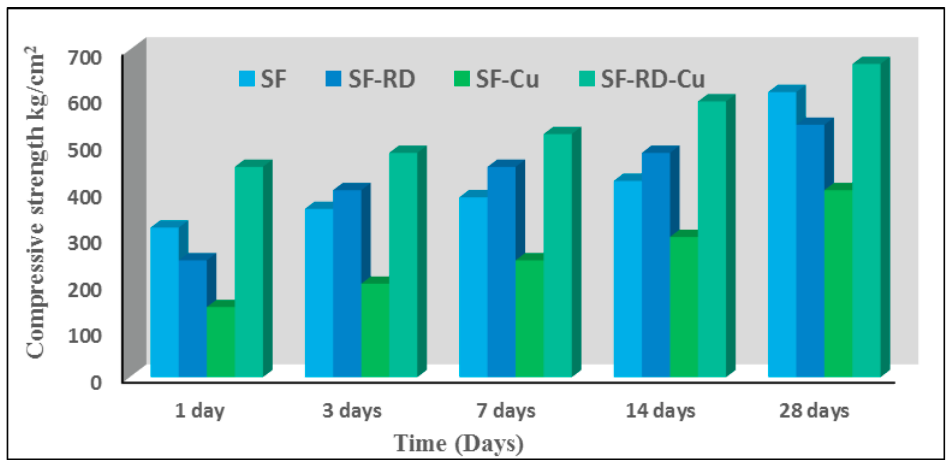
Figure 4. Compressive strength of different geopolymer cement mixes after curing at different hydration ages.